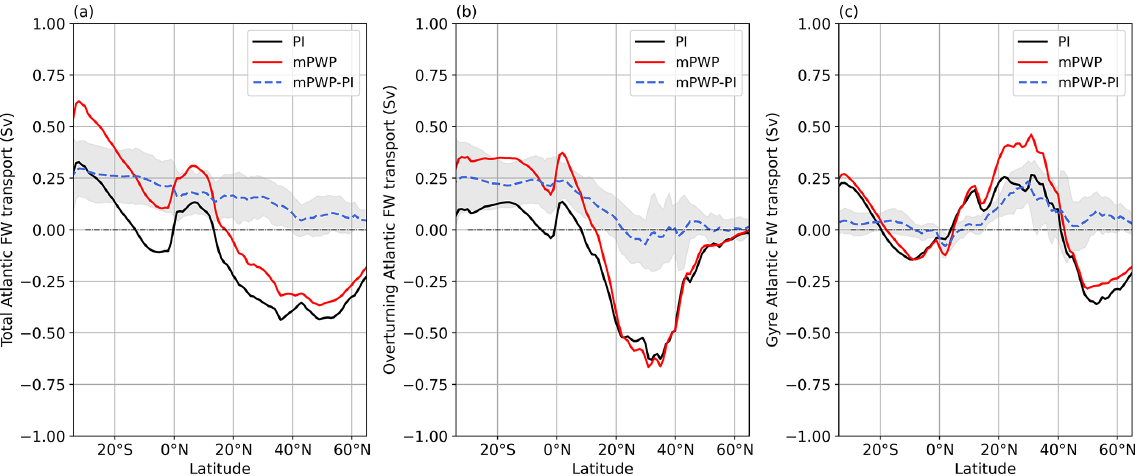
Figure 7. (a) MMM total Atlantic freshwater transport in the mid-Pliocene and pre-industrial and the difference. (b) MMM Atlantic fresh- water transport by overturning. (c) MMM Atlantic freshwater transport by wind-driven gyres. The shading indicates 1 standard deviation of deviation from the MMM difference by individual